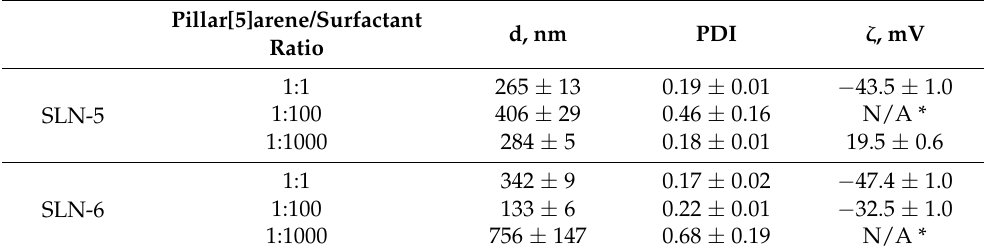
Table 3. Physicochemical characteristic of mixed SLN in water: d—hydrodynamic diameter by the dynamic light scattering (DLS) method, PDI—polydispersity index, ζ —zeta potential.